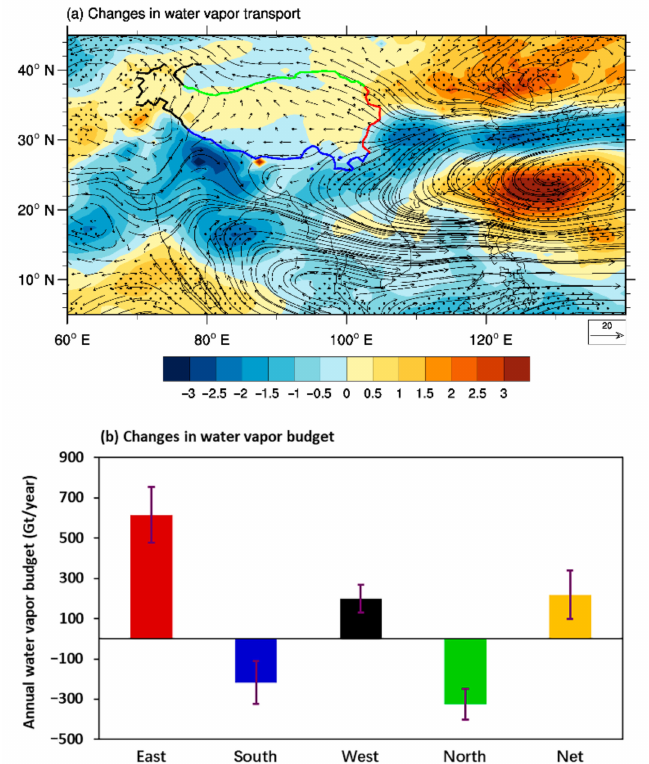
Figure 11. E ff ects of BC on ( a ) water vapor flux (kg / m / s) and ( b ) water vapor budget (Gt / year). The red, green, black and blue lines denote the west, east, north and south borders of the TP, respectively. The dots in ( a ) denote the changes in water vapor that are significant above the 90% confidence level. The purple short lines in the bar in ( b ) denote the error ranges from a negative to a positive standard